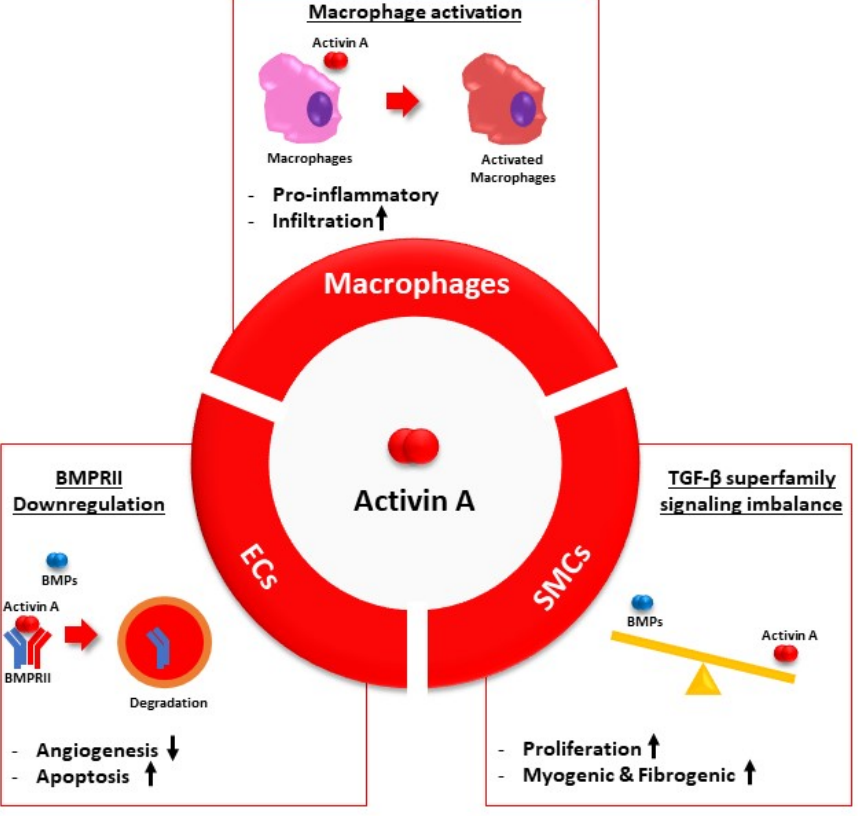
Figure 1. Summary of the activin A mechanism in PAH development. EC, endothelial cells. SMC, smooth muscle cells. BMPRII, bone morphogenetic protein receptor type 2. BMP, bone morphogenetic protein. TGF- β , transforming growth factor β . Arrow up, increase; arrow down, decrease.